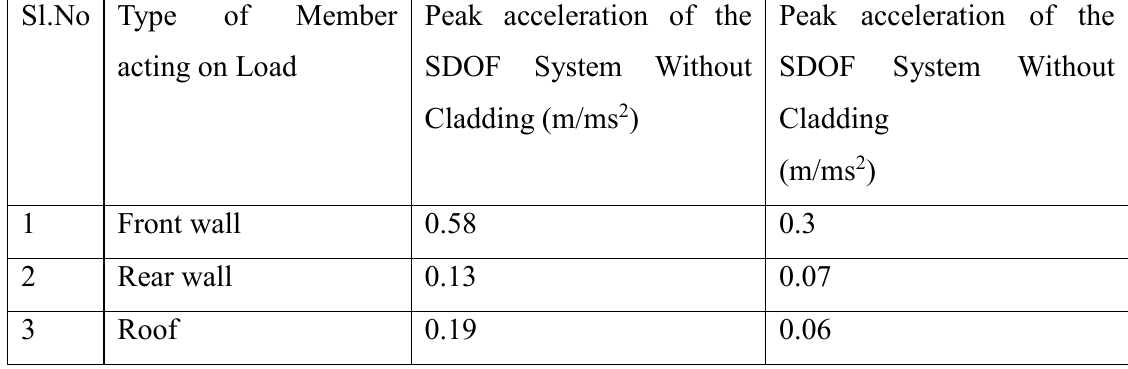
Reduction of acceleration of SDOF system subjected to Blast load by using Cladding